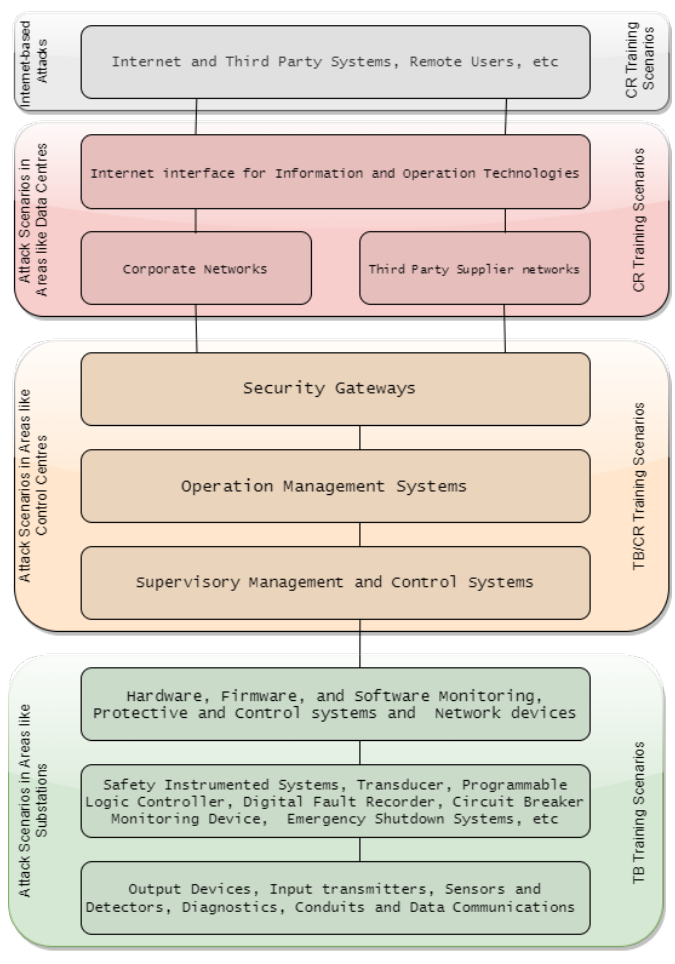
Figure 14. Attack scenarios